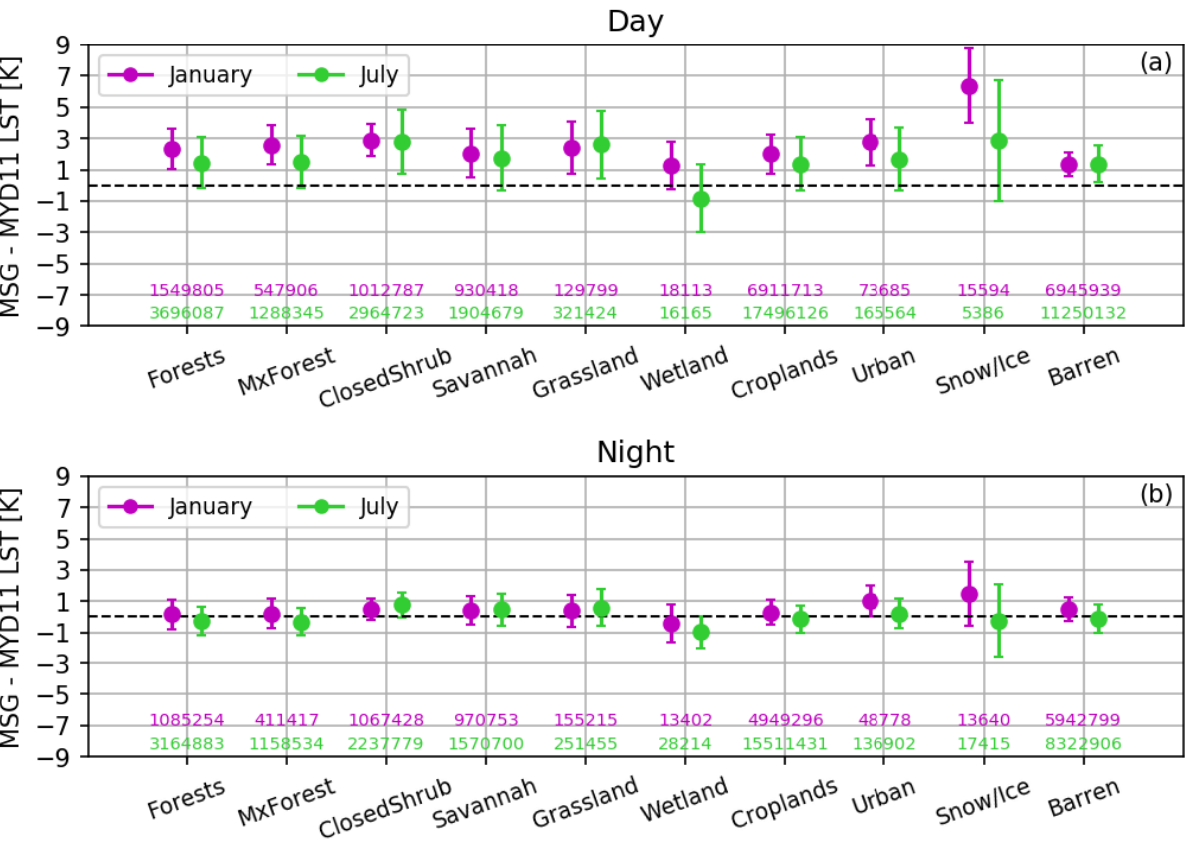
Figure 2. Statistics of the MSG LST-MODIS LST differences by land-cover type for January and July. Accuracy µ is represented with dots, and precision σ is represented as whiskers. Data for January is represented in purple, and for July in green. Separate statistics were computed for daytime ( a ) and nighttime ( b ). The numbers above the x-axis represent the number of matchups (i.e., MSG LST-MODIS LST valid pairs) used in January and June over each land-cover, respectively.